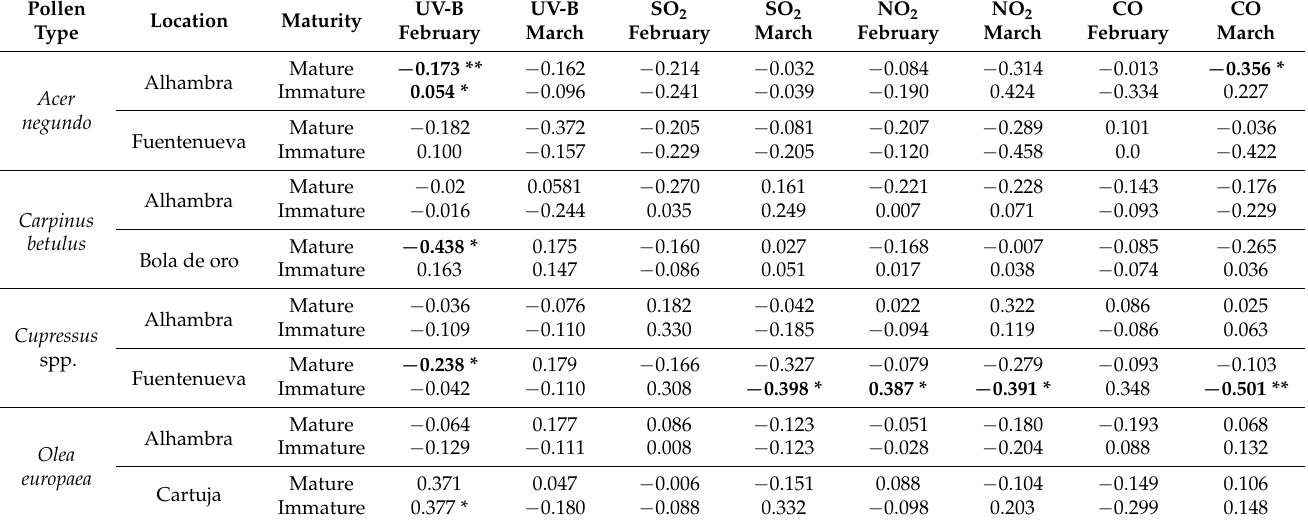
Table 6. Spearman’s correlation analysis between the percentage of mature pollen (Pyrogallol red) and the concentrations of atmospheric pollutants during the pre-flowering and flowering